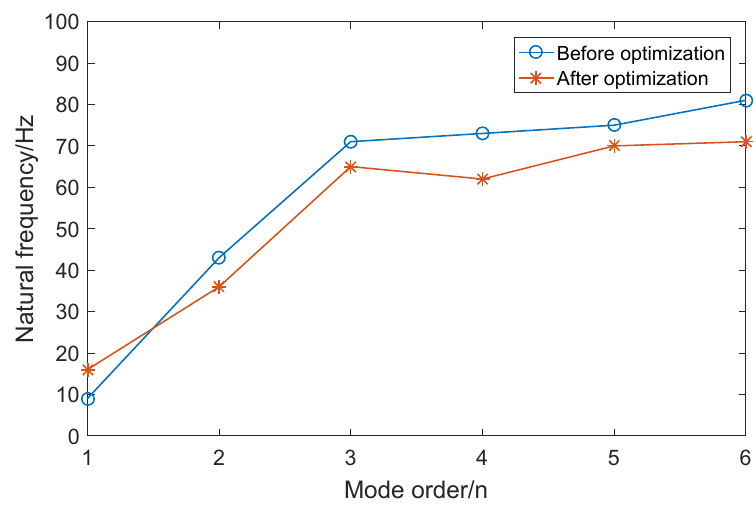
Figure 11. Comparison of natural frequencies results before and after optimization.